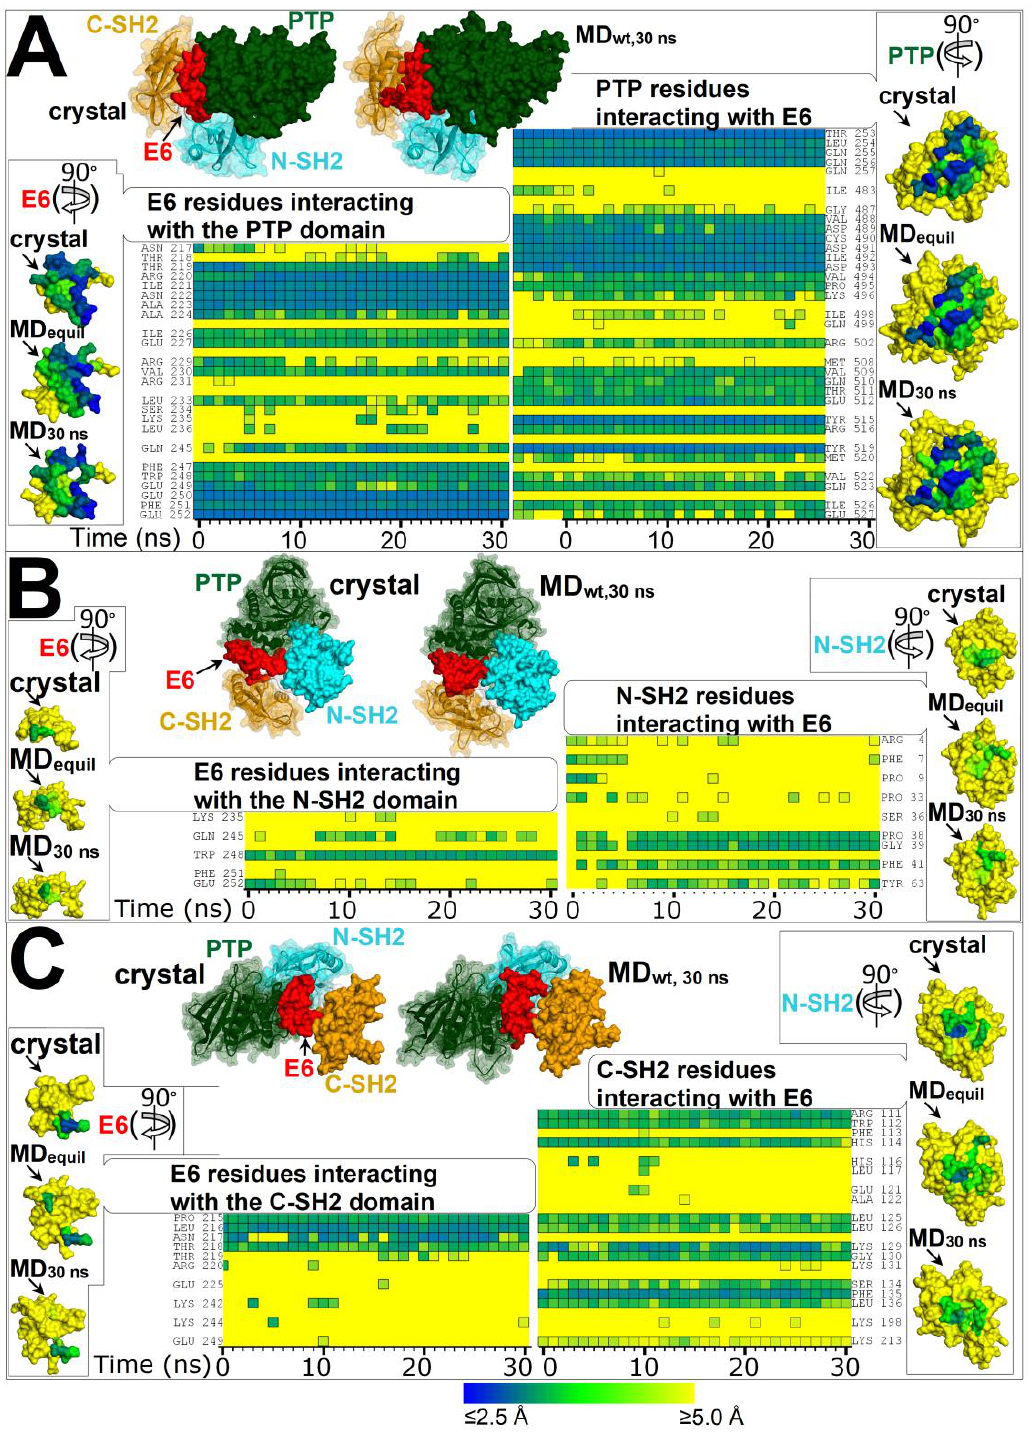
Figure 2. Residues forming the interfaces of E6 with domains PTP, N-SH2, and C-SH2 in the crystal structure of the self-inhibited SHP2 (PDB 2SHP) and at time intervals of the MD simulation of SHP2-wt. Heat maps representing the distances of E6 residues from each domain of SHP2 and vice versa calculated from conformers of the MD simulation (simulation time in the abscissa; time = 0 represents the distances calculated in SHP2 crystal structure). The color key for distances is shown at the bottom of the figure. ( A ) Residues at the interface between E6 and PTP. ( B ) Residues at the interface between E6 and N-SH2. ( C ) Residues at the interface between E6 and C-SH2. On top of each heat map is shown the self-inhibited SHP2 crystal structure and SHP2-wt at 30 ns of the MD simulation, both oriented for clear view of E6 binding to the various domains. Interacting residues are listed